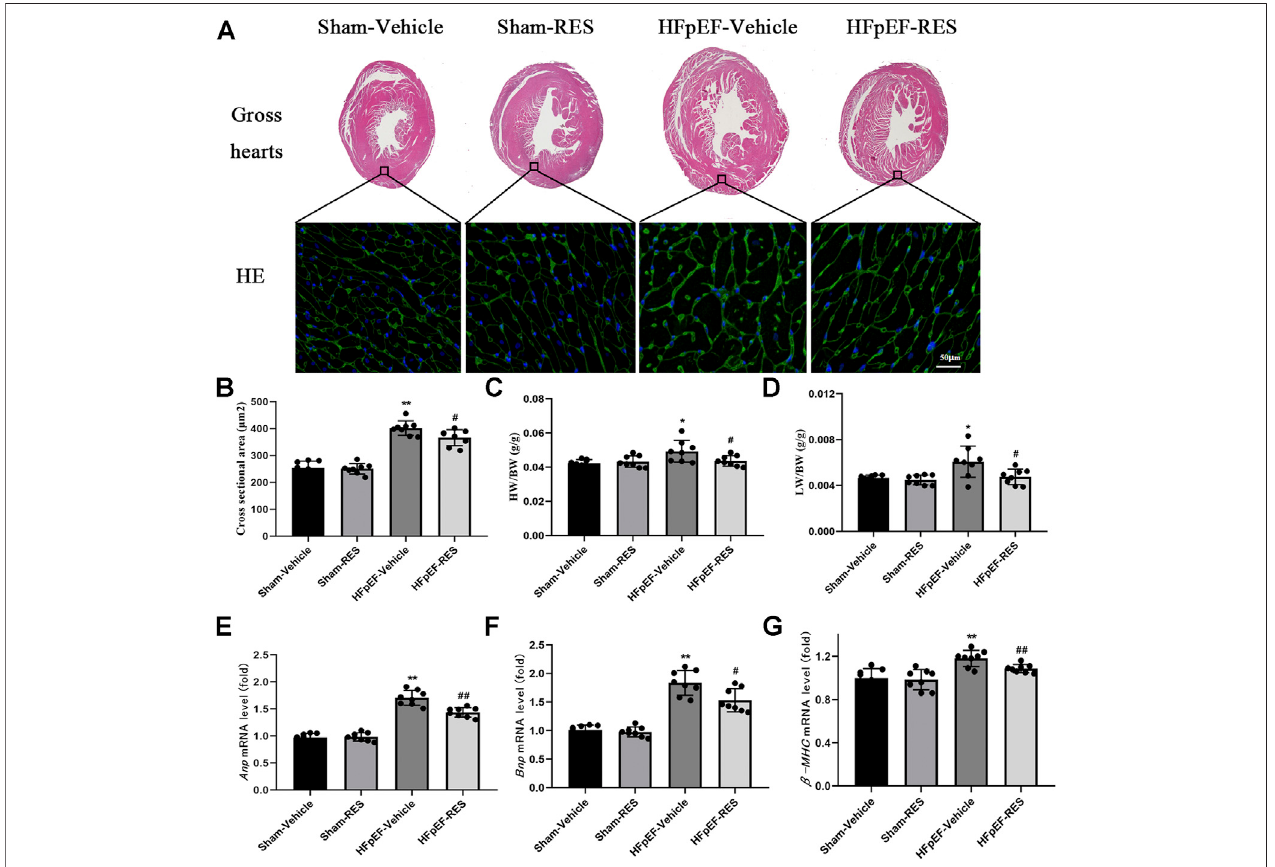
FIGURE 2 | Effect of RES on the HFpEF phenotype. (A) Representative images of gross hearts and WGA-stained heart sections. (B) Quantitative results of the left ventricularcross-sectional area( n (cid:2) 8per group). (C) HW/BW ratio( n (cid:2) 8per group). (D) LW/BWratiobetween the four groups ( n (cid:2) 8per group). (E – G) Results of ANP , BNP ,and β -MHC mRNAlevels( n (cid:2) 8pergroup).* p < 0.05vs.sham-vehiclegroup.** p < 0.01vs.sham-vehiclegroup.# p < 0.05vs.HFpEF-vehiclegroup.## p < 0.01vs. HFpEF-vehicle